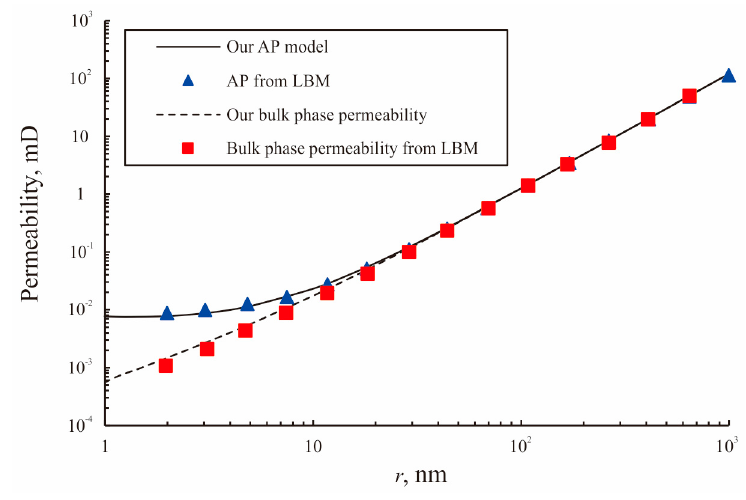
Figure 7. Model validation by comparing our model with LBM results.